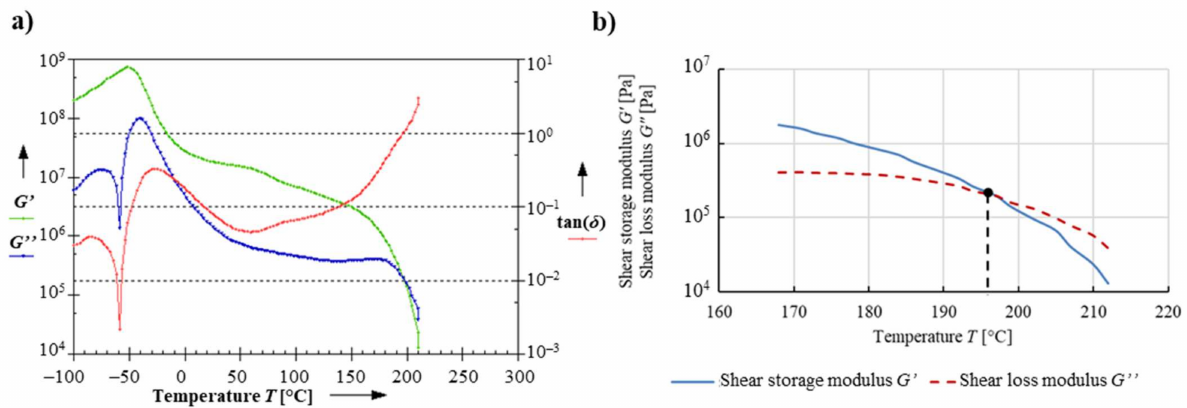
Figure 7. Determination of the temperature range for the DMTA test, ( a ) the result of the analysis in the temperature range from − 100 to 210 ◦ C, ( b ) determination of the intersection point of the shear storage modulus G (cid:48) and the shear loss modulus G (cid:48)(cid:48)